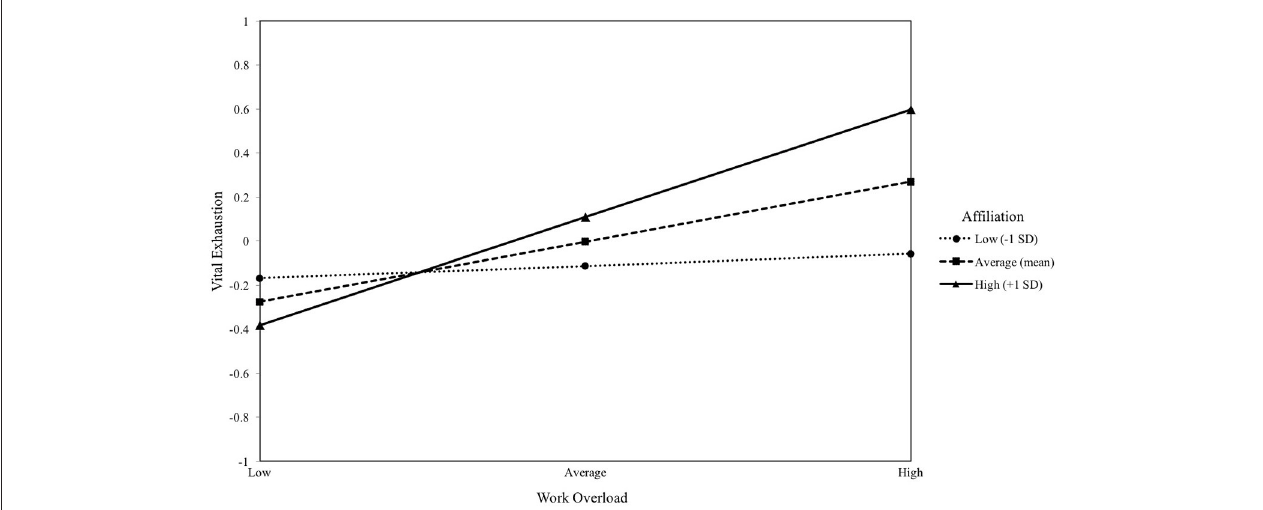
FIGURE 2 | The moderating effect of implicit affiliation motive on the association between work overload and vital exhaustion. Simple slopes of work overload predicting vital exhaustion for 1 SD below the mean of affiliation, at the mean of affiliation, and 1 SD above the mean of affiliation.